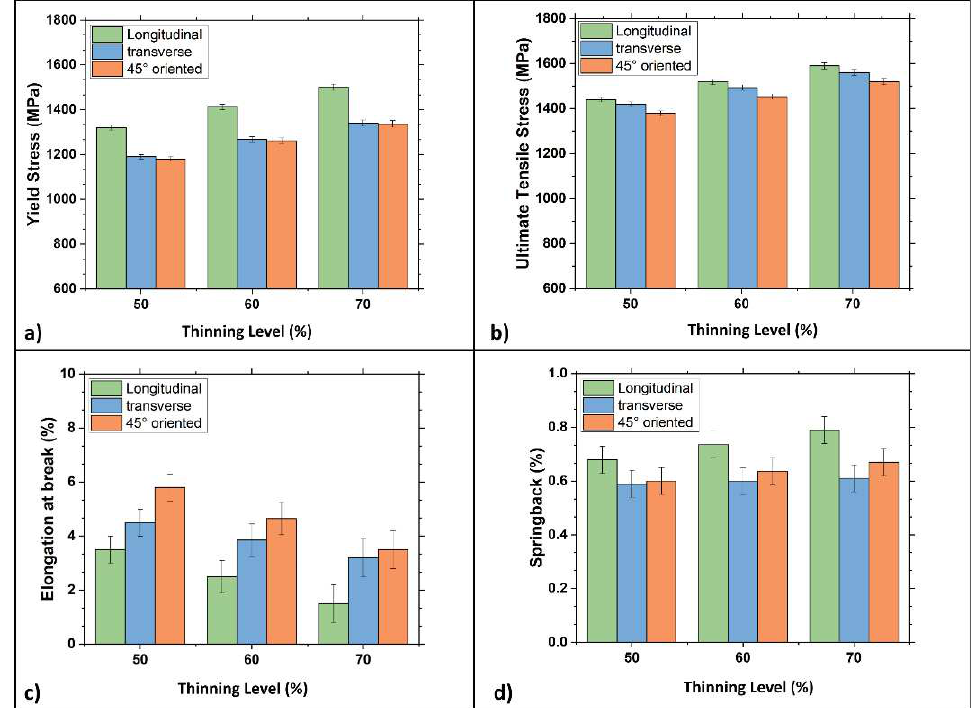
Figure 9. Mechanical properties as a function of metallurgical orientation after thinning the DP steel by 50, 60 and 70% with w/t = 4.5. ( a ) yield stress, ( b ) ultimate tensile stress, ( c ) elongation ant break and ( d ) springback effect.